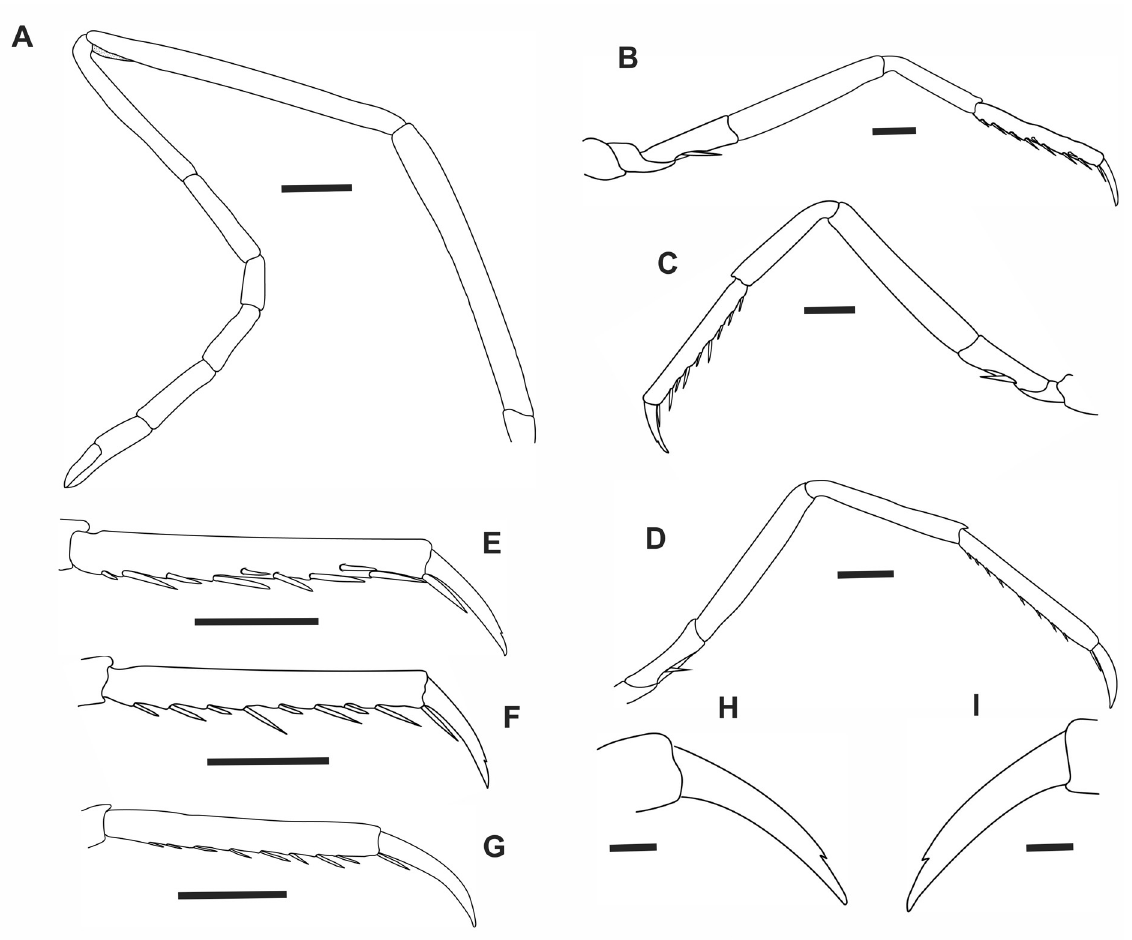
Fig. 3. Alpheus ramosportoae sp. nov., paratype, ♂, from seamounts of the North Chain, Ceará, northeastern Brazil (MOUFPE 13703). A . Second pereiopod, lateral view. B . Third pereiopod, lateral view. C . Fourth pereiopod, lateral view. D . Fifth pereiopod, lateral view. E–G . Third to fifth pereiopods, detail of propodus, lateral view. H–I . Third and fourth pereiopods, detail of dactylus. Scale bars: A–G = 0.5 mm; H–I = 0.25